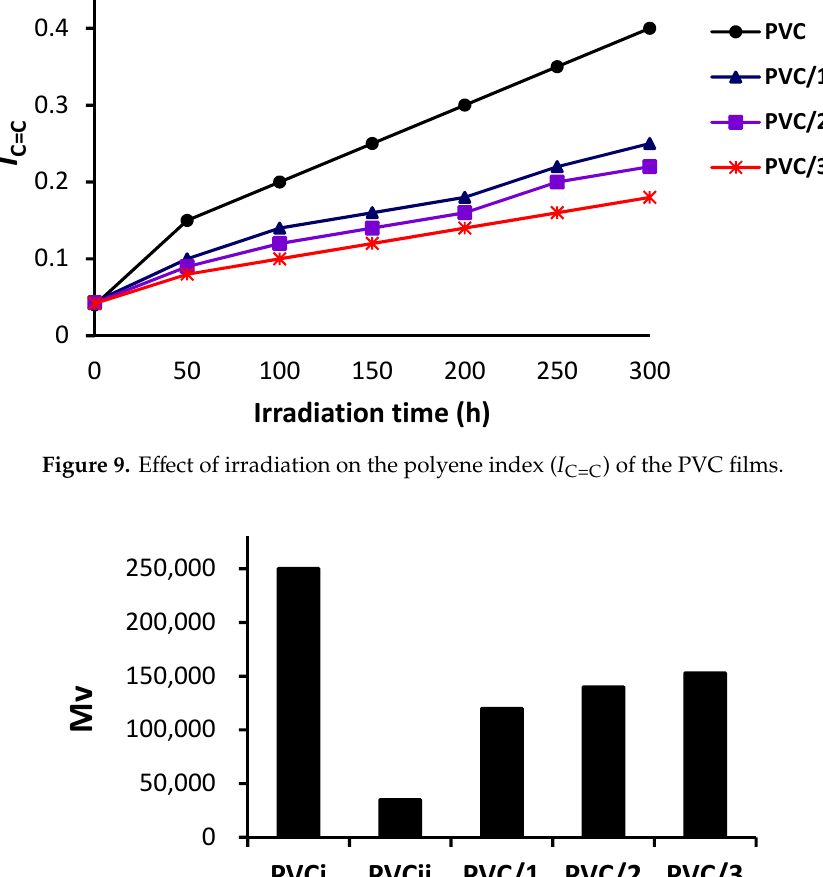
Figure 10. E ff ect of irradiation on the average molecular weight ( M V ) of PVC films. PVCi and PVCii Figure 10. Effect of irradiation on the average molecular weight ( 𝑀(cid:3365) (cid:2906) ) of PVC films. PVCi and PVCii correspond to the M V values of the blank PVC film before and after irradiation, correspond to the 𝑀(cid:3365) (cid:2906) values of the blank PVC film before and after irradiation, respectively.